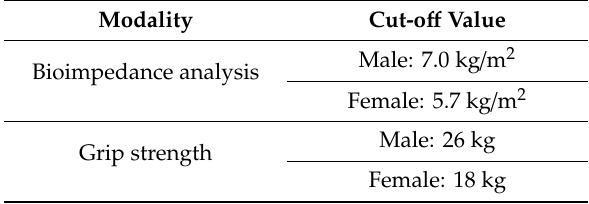
Table 1. Cut-o ff values of bioimpedance analysis and grip strength according to